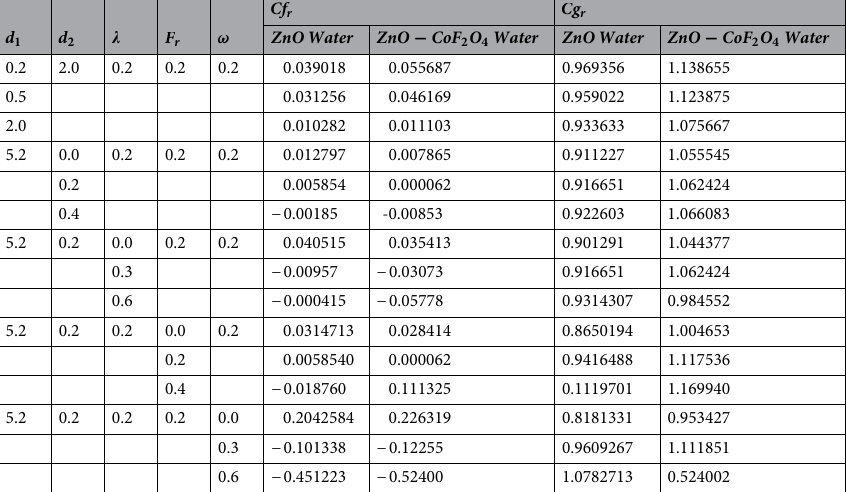
Table 5. Skin frictions ( Cf r and Cg r ) numerical values versus various